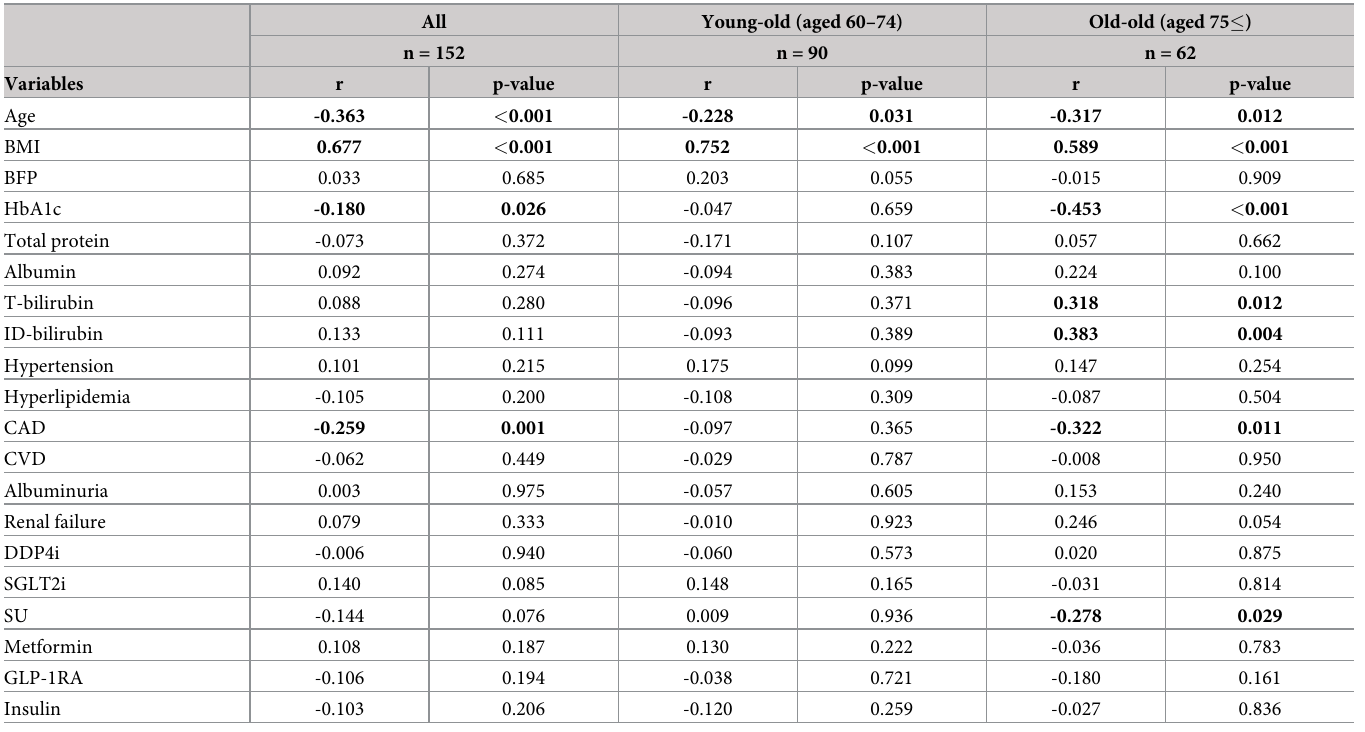
Table 2. Univariate analysis of factors associated with skeletal muscle mass index (SMI) in